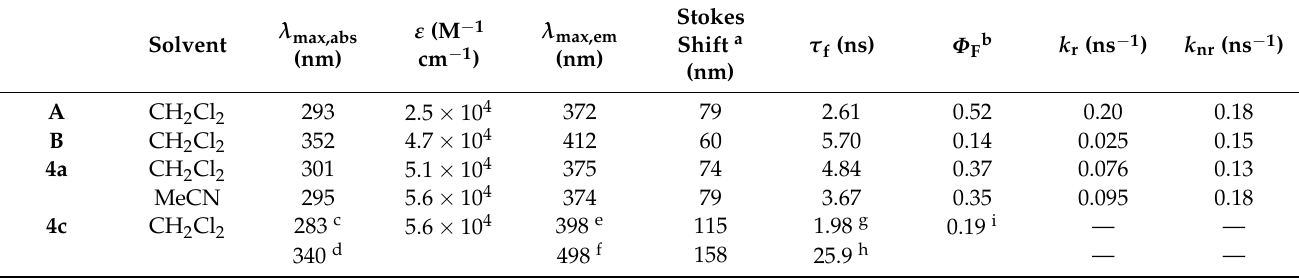
a Computed as λ b Against quinine sulfate Φ c Abs max,em − λ max,abs ; max (calixarenic F = 0.546 in H 2 SO 4 0.5 M; macrocycle + pyrene band); d Absmax (pyrene band); e Corresponding to the monomer band; f corresponding to the excimer band; g λ em = 398 nm; h λ em = 498 nm; i overall (monomer + excimer)